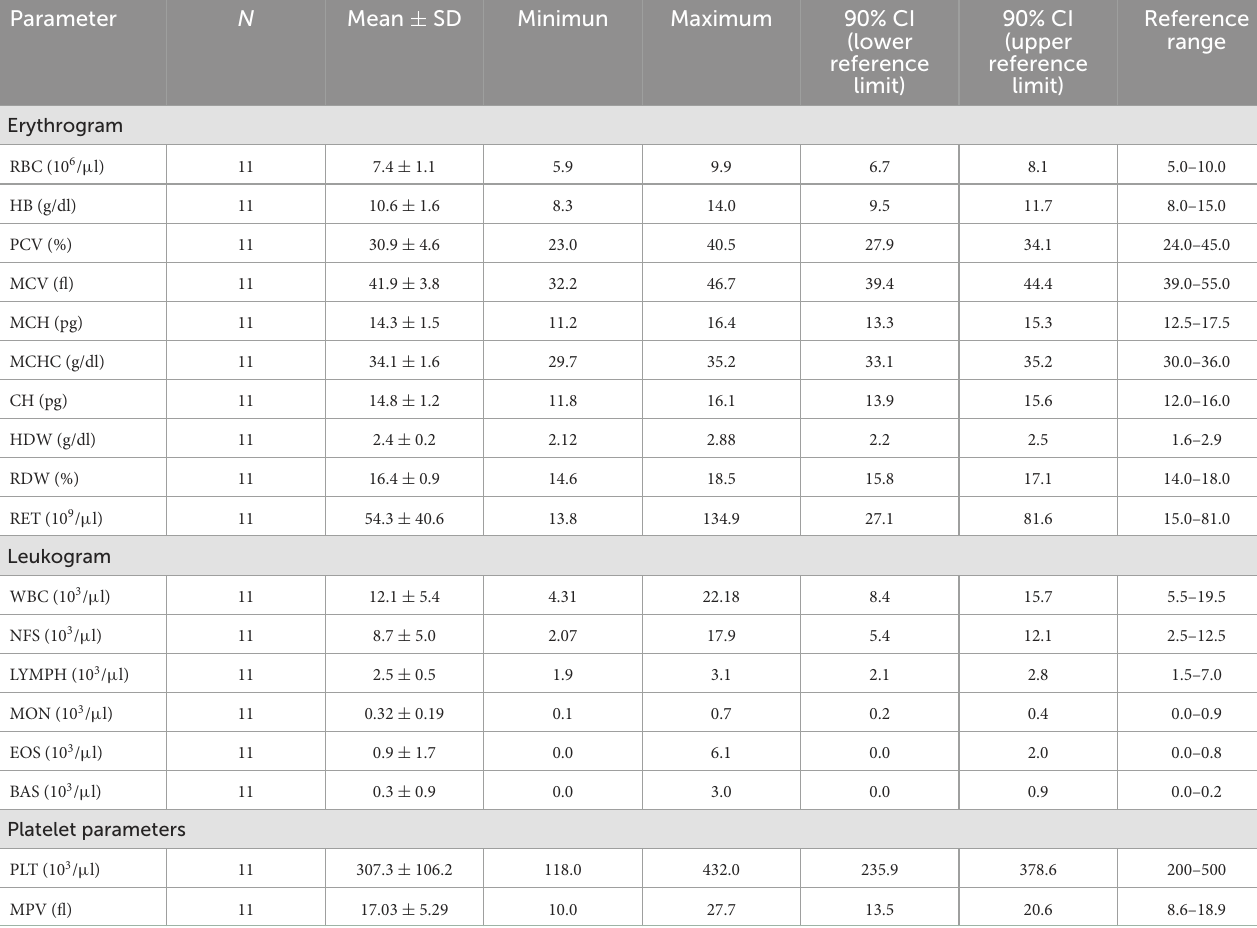
TABLE 1 Mean ± SD of red blood cell (RBC) count, hemoglobin concentration (HB), packed cell volume (PCV), mean corpuscular volume (MCV), mean corpuscular hemoglobin (MCH), mean corpuscular hemoglobin concentration (MCHC), mean hemoglobin content (CH), hemoglobin concentration distribution width (HDW), red blood cell distribution width (RDW), reticulocytes absolute count (RET), white blood cell (WBC), neutrophil (NFS), lymphocyte (LYMPH), monocyte (MON), eosinophil (EOS), basophil (BAS) and platelet (PLT) counts, and mean platelet volume (MPV) in whole blood samples (WB) in 11 FeLV-positive cats ( n = 11).